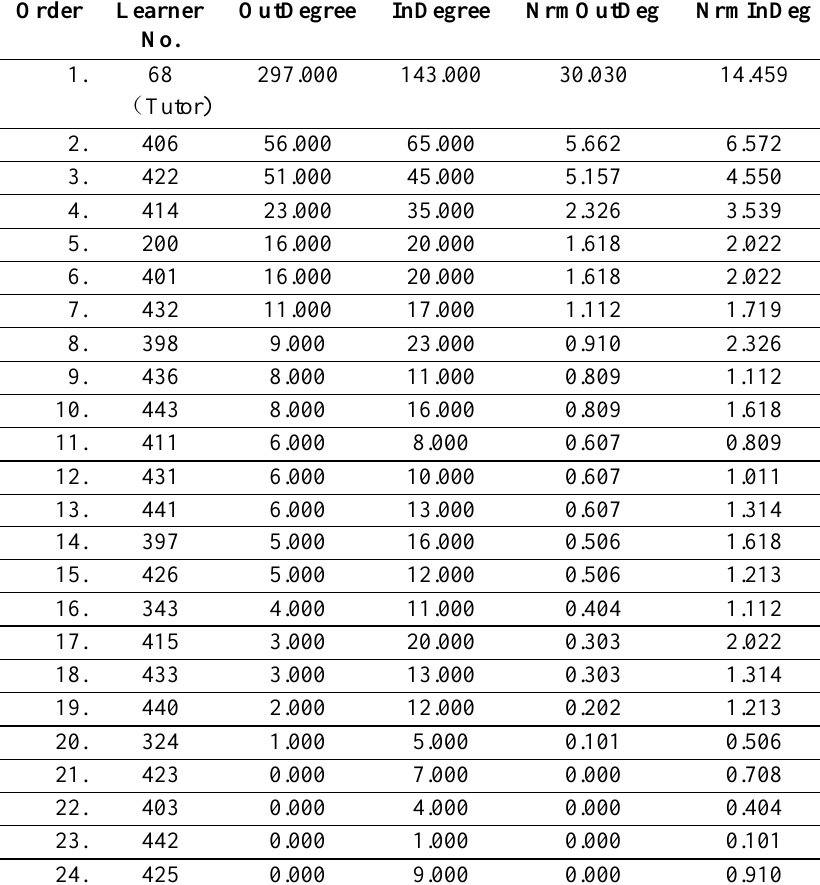
OutDegree and InDegree of learners in